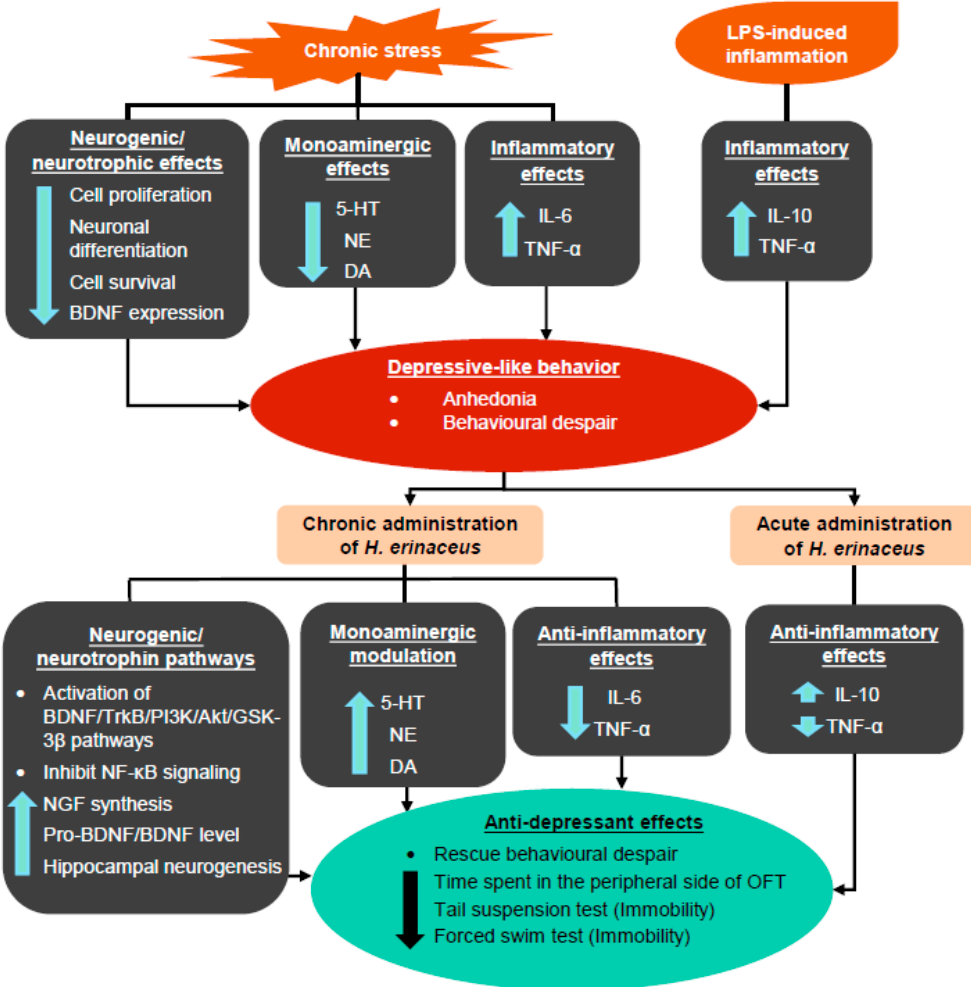
Figure 4. Summary of the generation of depressive-like behaviors induced by chronic stress and LPS-induced inflammation, as well as the mechanisms of antidepressant-like e ff ects induced by H. erinaceus. The up arrow indicates an increase in the activity / expression level, while the down arrow indicates a decrease in the activity / expression level.